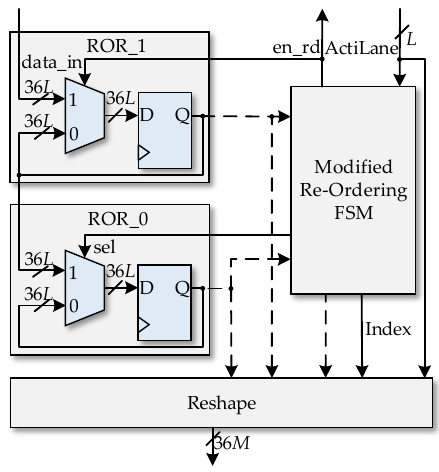
Figure 6. Description of the modified word re-ordering block.